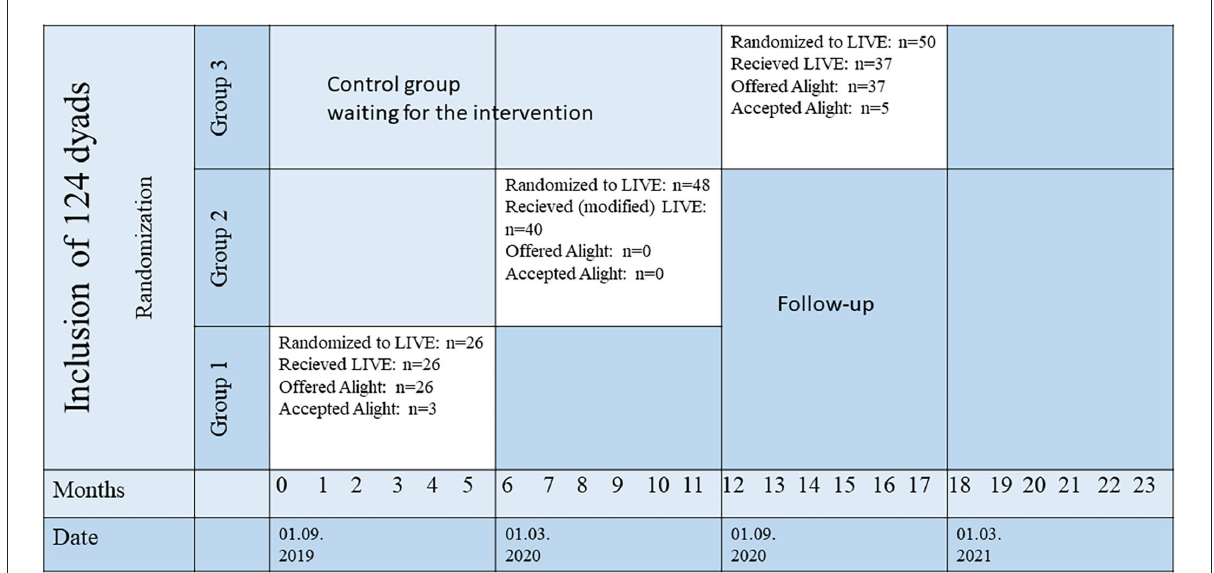
FIGURE3 Acceptability of the Alight application in the stepped wedge randomized controlled LIVE@Home.Path trial. A total of 124 dyads of persons with dementia and their caregiver were included in Bergen municipality before 01/09/2019 and randomized in time to receive the 6-month LIVE intervention in three groups. Group 1 received the intervention from 01/09/2019 to 28/02/2020, Group 2 received a modified version of the intervention without Alight from 01/03/2020 to 31/08/2020 (COVID-19 restrictions), and Group 3 received the intervention from 01/09/2020 to 28/02/2021. Demographic and clinical data from the dyads utilized in this study were collected before start of intervention groups 1 and 3 (months 0 and